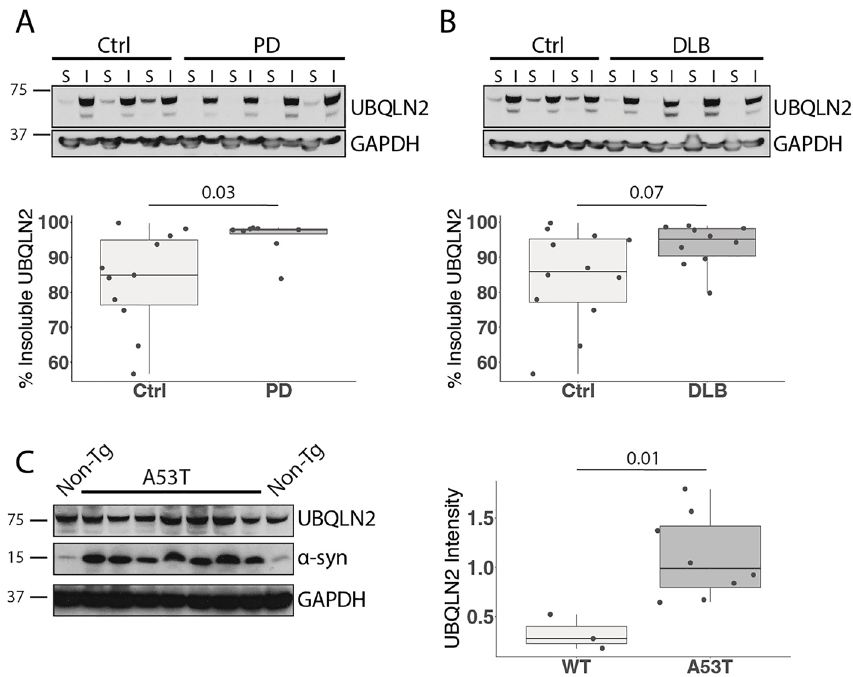
Figure 1. UBQLN2 insolubility is increased in Parkinson’s disease human tissue and mouse models. ( A , B ) Western blots of lysates from post-mortem cingulate cortex of PD and DLB patients show an increase in insoluble UBQLN2 in ( A ) PD (n = 8) and ( B ) DLB (n = 10) compared to age-matched controls. S PBS soluble, I PBS insoluble/sarkosyl soluble. ( C ) Representative western blot of whole brain lysate from mice overexpressing human mutant α-syn A53T solubilized in sarkosyl (n = 8) shows elevated levels of insoluble UBQLN2 compared to non-transgenic controls (n = 3). Western blots were cropped to focus on protein(s) of interest. Uncropped Western blots are shown in Supplemental Figure